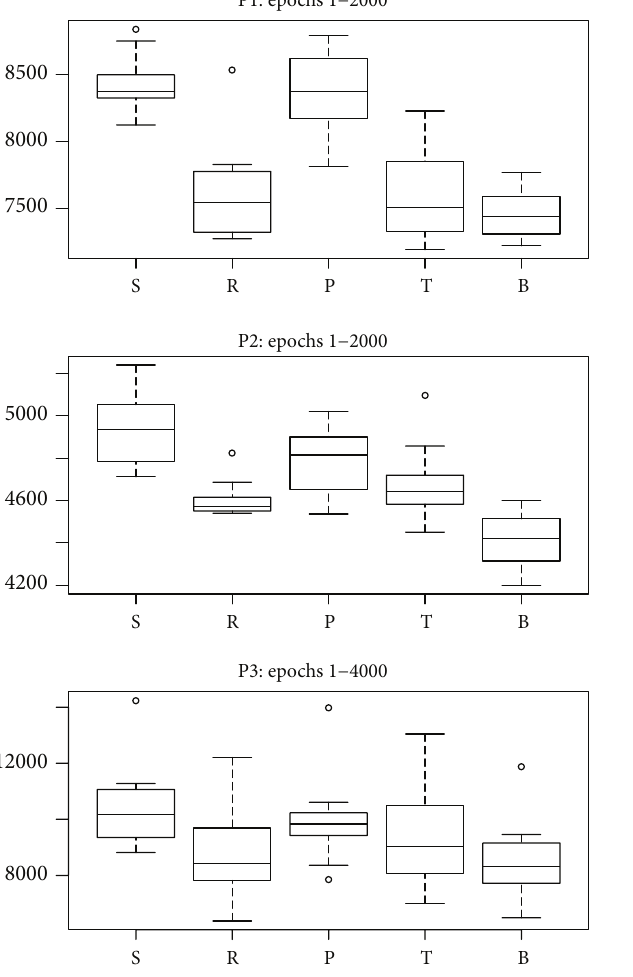
Figure 8: Average costs in late periods. Table 2: Experimental